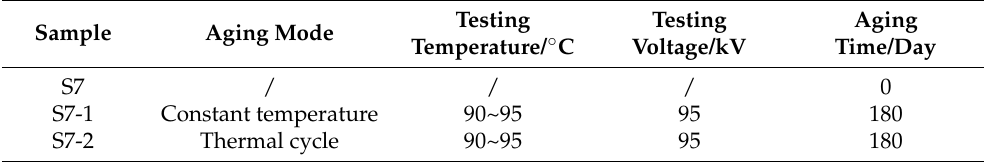
Table 1. Critical thermal parameters and ampacity of the